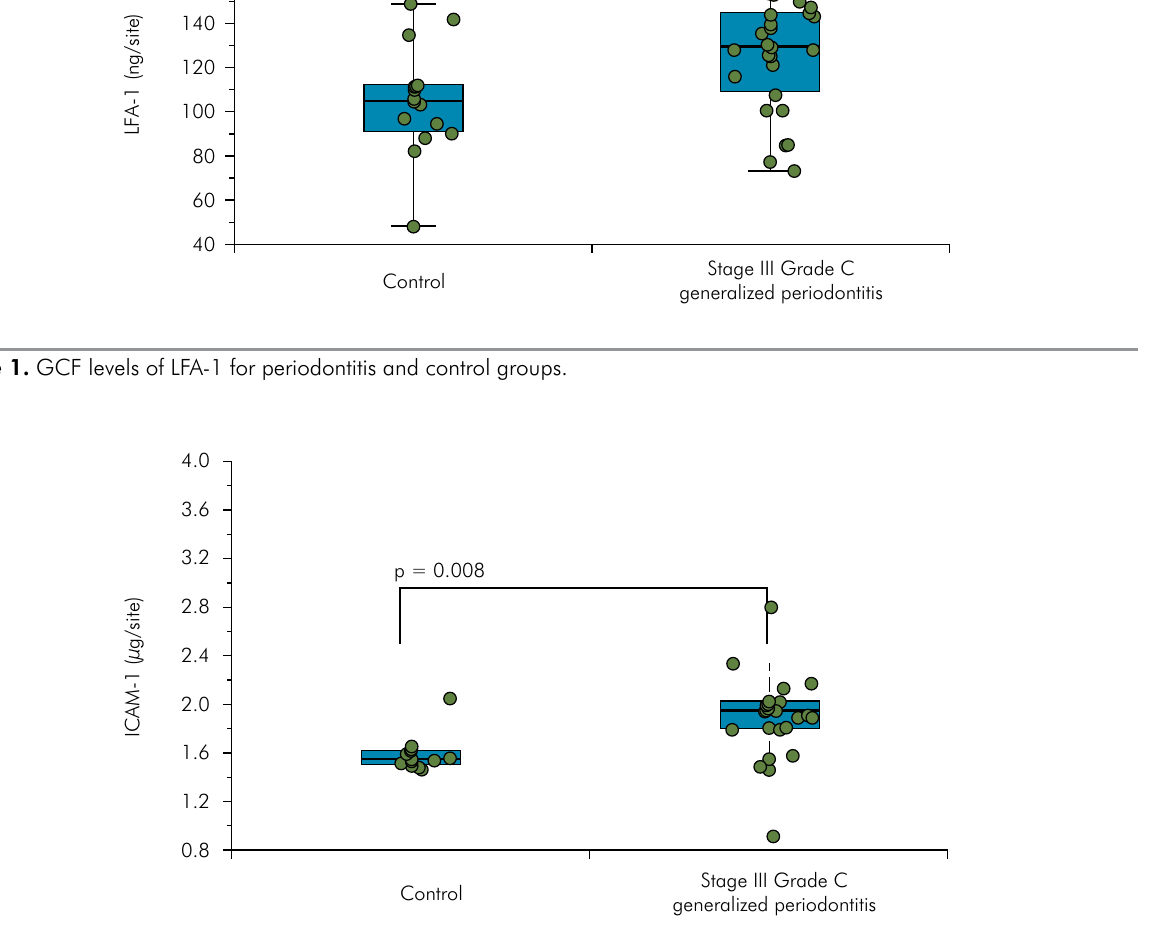
Figure 2. GCF levels of ICAM-1 for periodontitis and control